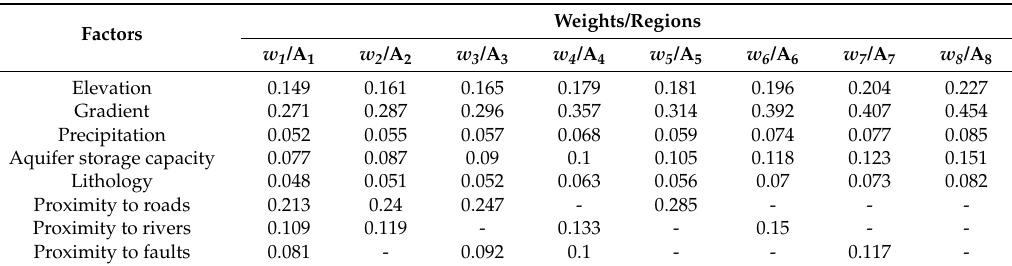
Figure 5. Regions divided by the locational elements. Figure 6. Regions divided by the locational elements. Table 6. Weights of each factor in different regions. Table 6. Weights of each factor in different